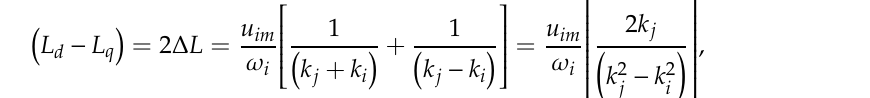
Figure 6. The PMSM model in γδ reference frame that is used as basis to form the sliding mode observer (SMO) for speed and position estimation. 5.3. Very Low Speed Response with Torque Load Simulation results presented in Figure 7d-f show the PMSM speed response during speed changes in the presence of external torque 1Nm. Here the speed is changed stepwise from 0 rad/s to π /2 rad/s (0.25Hz) and from π /2 rad/s to - π rad/s (0.5 Hz) at t 2 = 2s. Also the external torque of 1Nm is applied at t 1 = 1 s and it is removed at t 3 = 3 s. The rotor speed and angle are shown in Figure 7d,e, respectively, while the HF stator currents including modulated and k i are shown in Figure 7f. The very small speed and angle errors show the robustness of the proposed estimation scheme. Also, as expected the frequency of derived current signals is double that of the injected one after modulation. It is worth noting here that during the transition from π /2 rad/s to - π rad/s the observer behavior is robust and stable even in presence of torque disturbance. The observer keeps converging fast with very small angle errors between the synchronous dq (real) and γδ estimated reference frames.